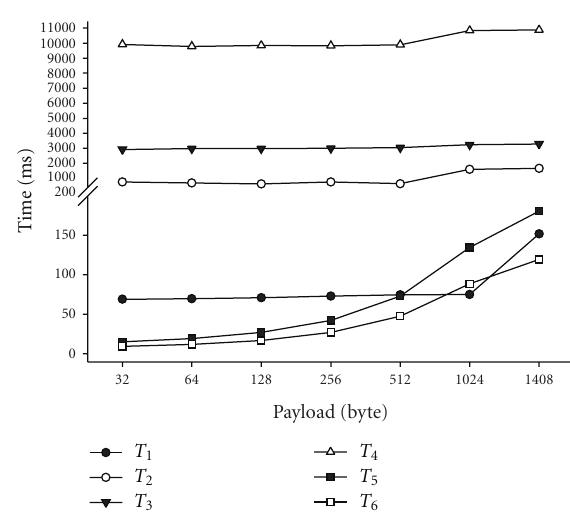
Figure 13: Timing parameters for Figures 11 and